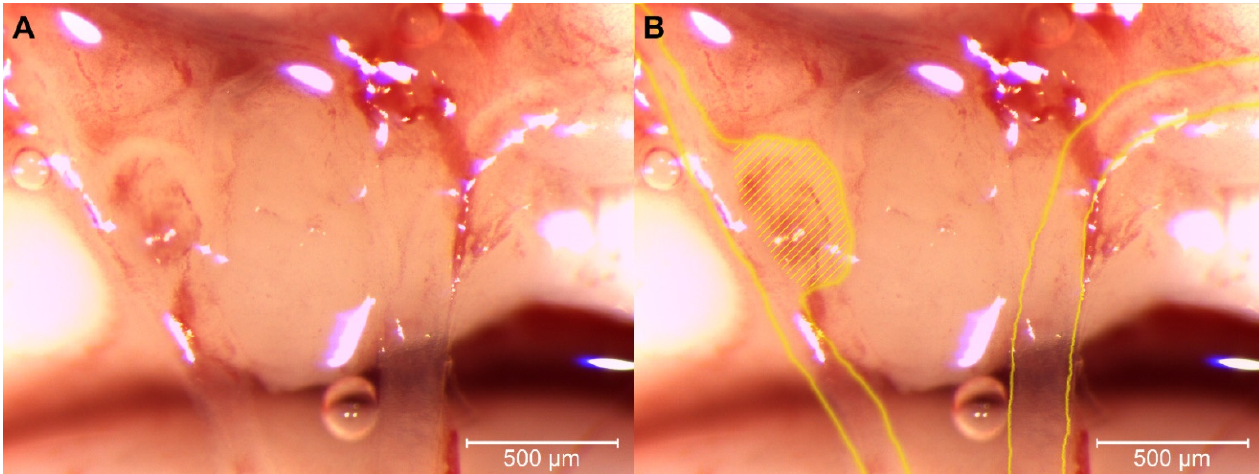
Figure 3. Light microscopy (magnification: 50×) of the brain of EDNRA + HT rat after observation period of 12 weeks. The basilar artery (not pictured) branches into both posterior cerebral arteries [32]. A saccular aneurysm with detritus evolved at the right posterior communicating artery. ( A )